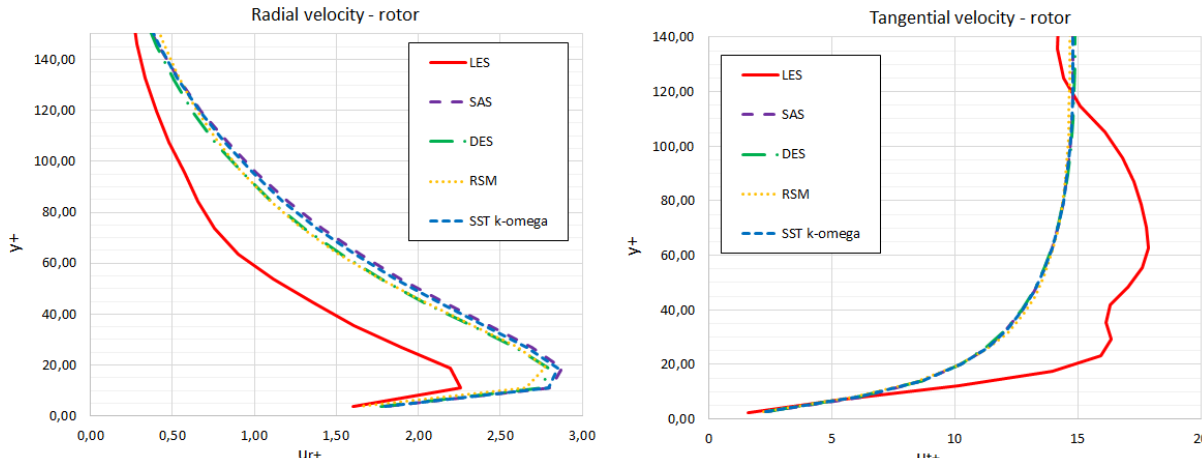
Fig. 12. Velocity profiles in rotor boundary